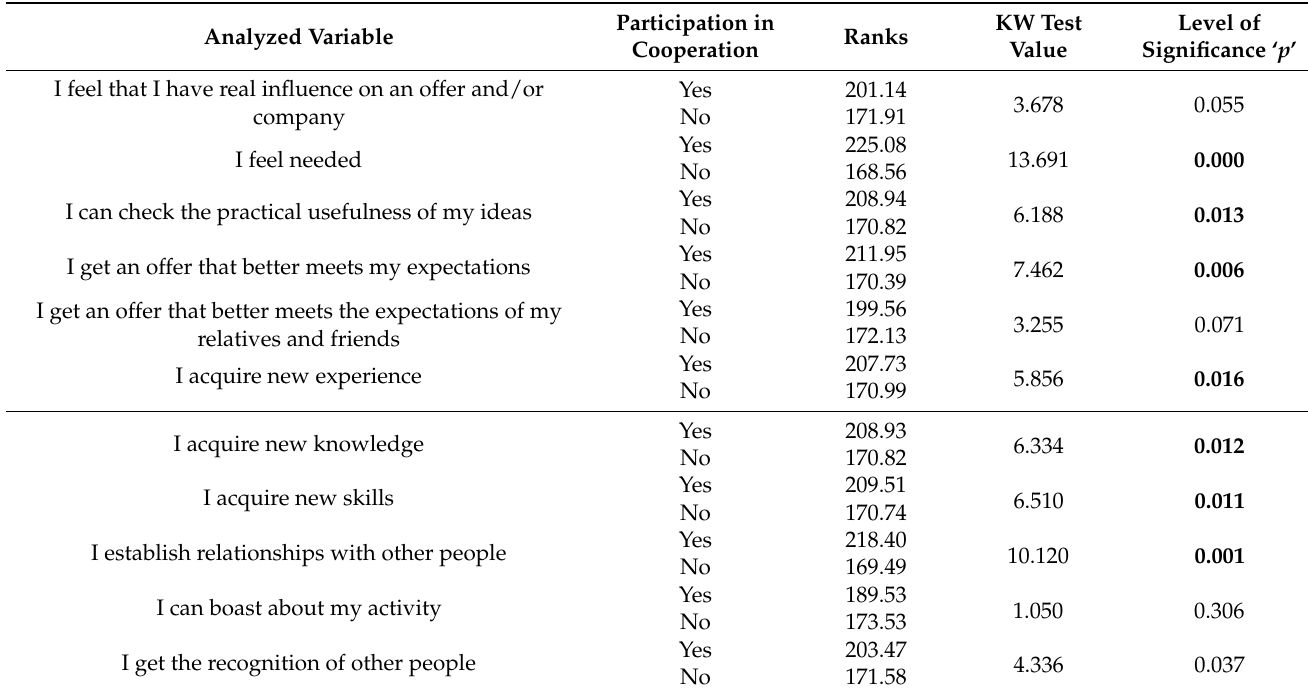
Table 6. Analysis of significance of differences between respondents’ opinions relating to the needs satisfied due to cooperation with offerors, according to the criterion of respondents’ previous participation in such